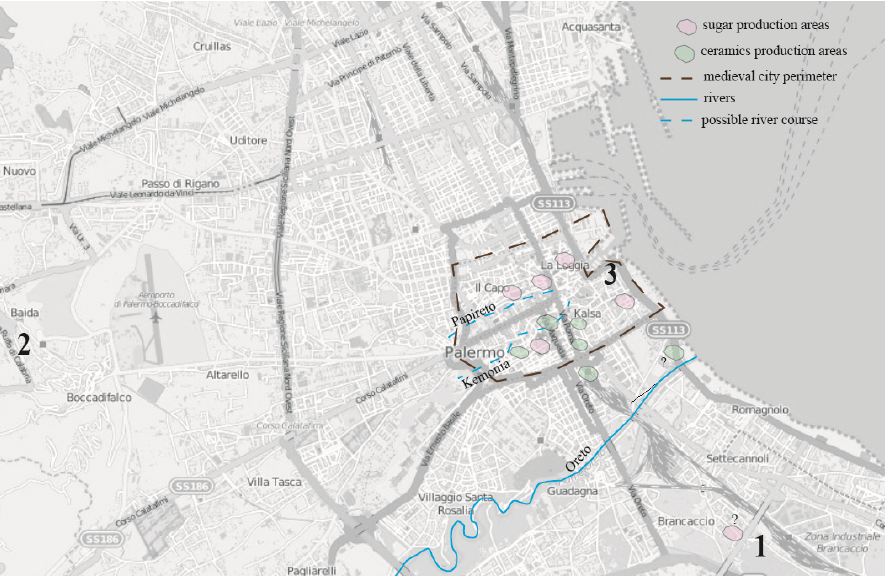
Figure 19. Map of Palermo with the sites sampled (1: Castello della Favara in Maredolce, 2: Con- vento di Baida, 3: Palazzo Steri–Chiaramonte), and the areas of sugar production according to archival sources [18,28] and the areas of ceramics production according to archival and archaeological sources [117–120]. The localisation of the areas has to be considered to be